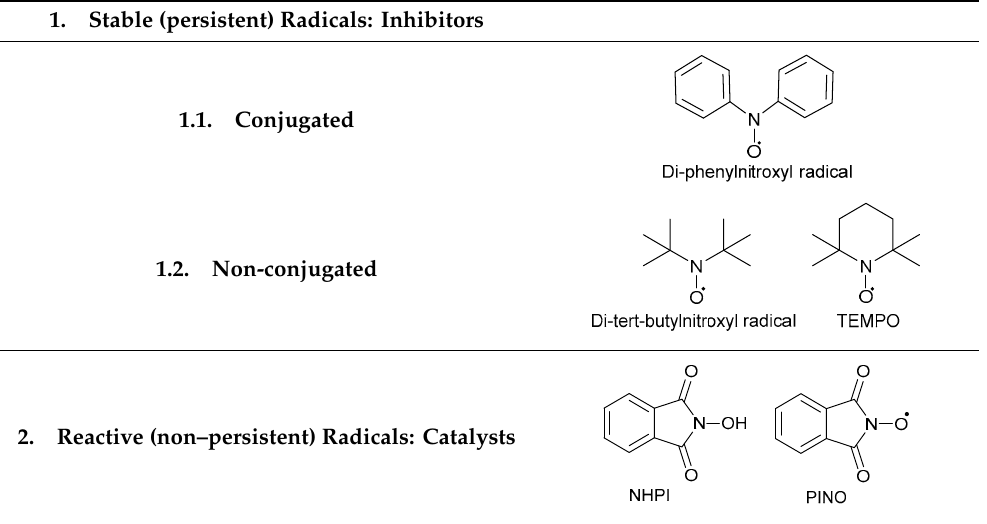
Table 1. A summary of the two types of nitroxyl radicals, based on their properties and applications [33]. Reproduced with permission from Sheldon and co-workers. Copyright Elsevier, 2006.